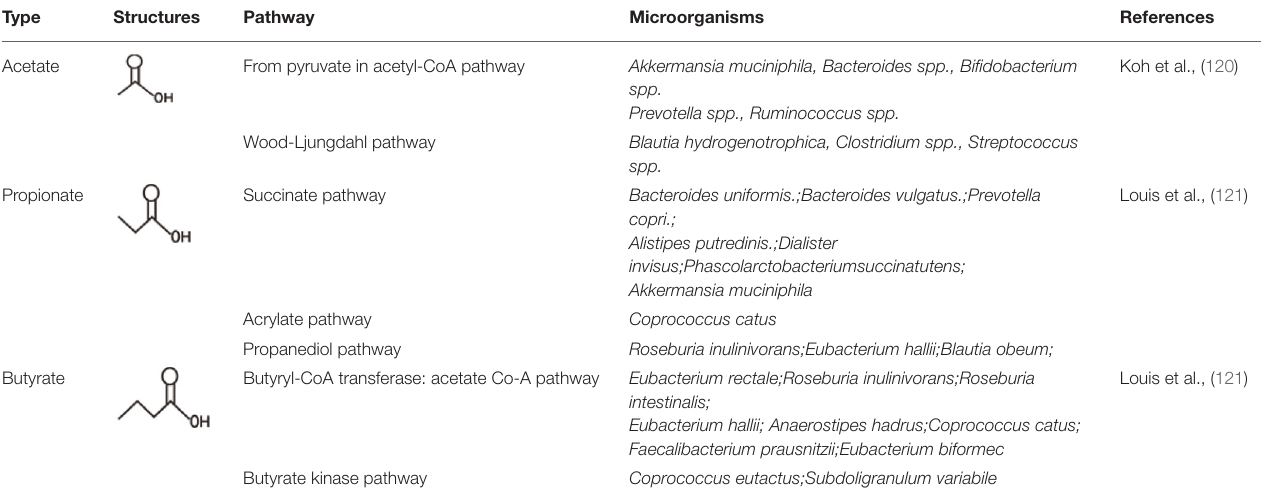
TABLE 2 | Pathways of main SCFA production and their related microorganisms.